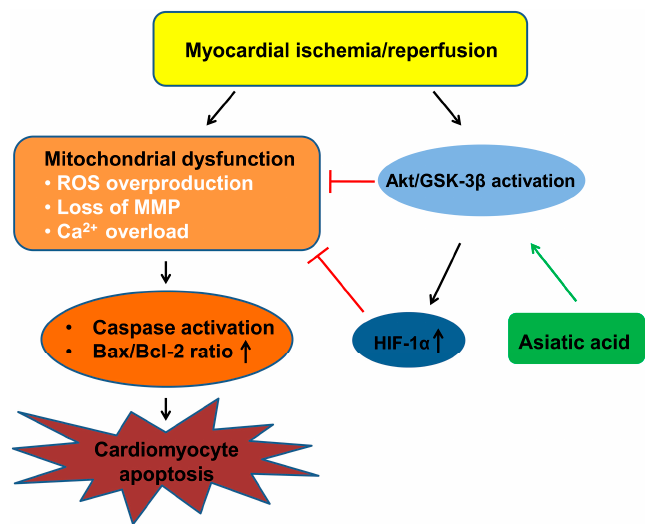
Figure 6. A schematic diagram of the mechanism by which asiatic acid prevents cardiomyocyte apoptosis. Ischemia/reperfusion induces mitochondrial dysfunction and triggers cardiomyocyte apoptosis. Asiatic acid activates the Akt/GSK-3 β signal pathway and increases HIF-1 α levels, thus suppressing the mitochondrial-mediated apoptosis.